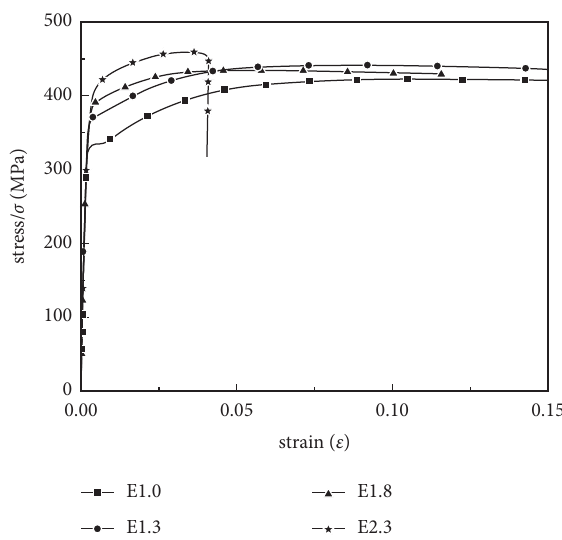
Figure 4: Stress-strain relationships of elliptical steel